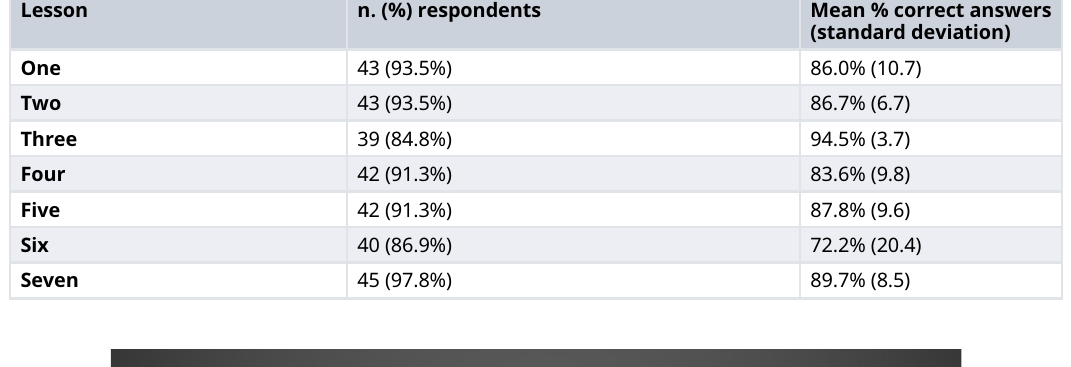
Table 6. Exercise book: % of correct answers from responding children (for each lesson). Lesson